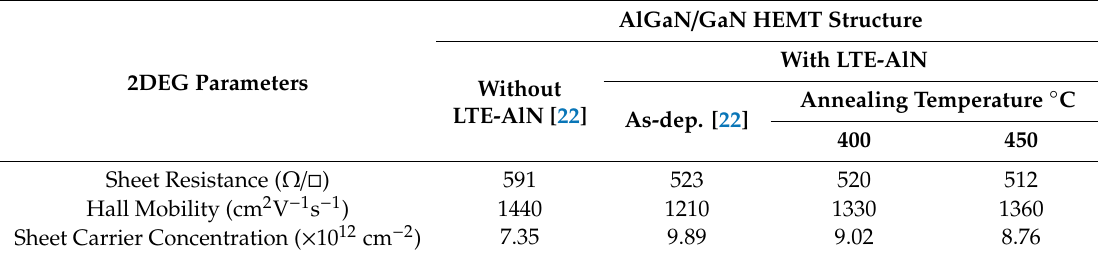
Table 1. 2DEGproperties of AlGaN / GaN with and without AlN and its post deposition annealing at 400 ◦ C and 450 ◦ C for 300 s in N 2